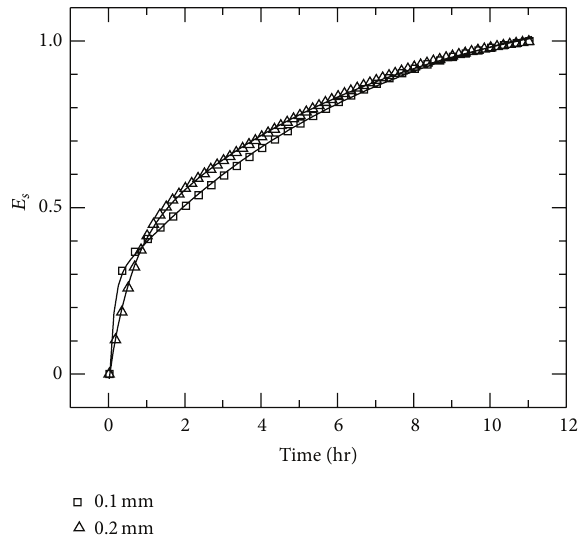
Figure 8: Evolution of scaled relaxation potential with coating thickness as a parameter. Superposed are the fits of the expression to the simulated